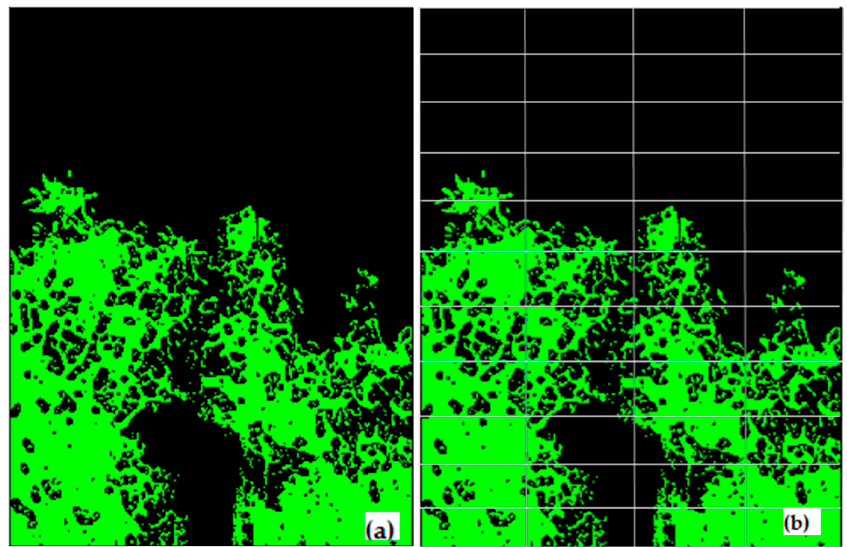
Figure 3. ( a ) Final image sky (black) and canopy area (green) segmented, and ( b ) subdivision of image into n number of sub-images for gap analysis.